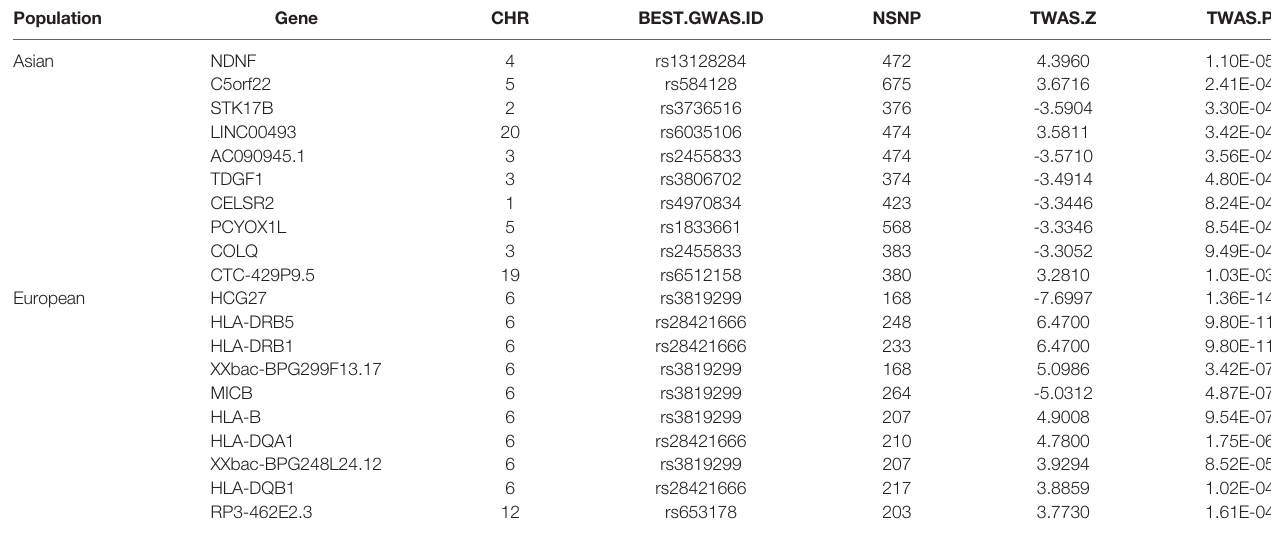
The large-scale Genome-Wide Association Study (GWAS) summary data for juvenile idiopathic arthritis (JIA) acquired from Asian and European cohort studies, including 898 JIA patients and 346,102 controls. The TWAS.P and TWAS.Z values were calculated by the FUSION approach (http://gusevlab.org/projects/fusion/). TWAS, transcriptome-wide association study; GWAS, Genome-Wide Association Study; JIA, juvenile idiopathic arthritis; TWAS P, TWAS P-value; TWAS Z, TWAS Z-score; NSNP, number of SNPs in the